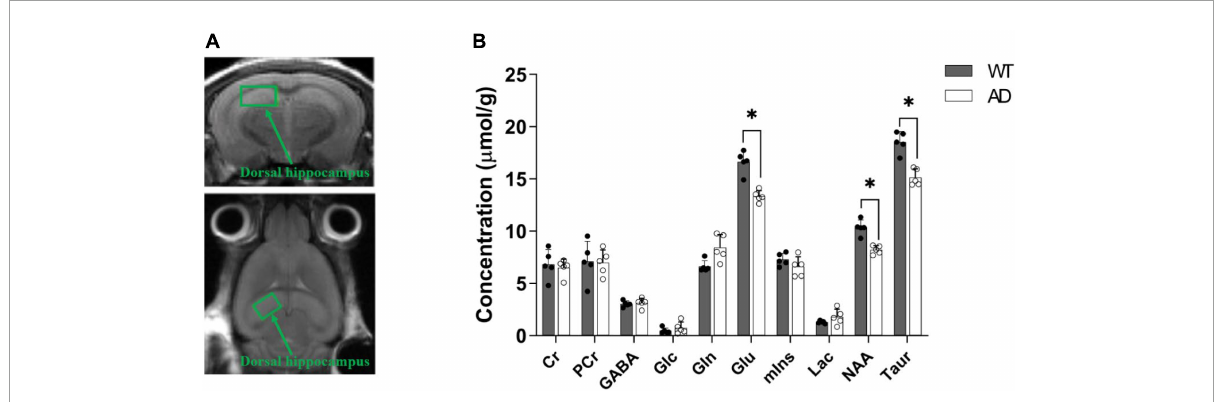
FIGURE7 Definition of the volume of interest (i.e., dorsal hippocampus) in magnetic resonance spectroscopy (MRS) (A) . Comparison of the neurochemical profiles between the wild-type (WT) and APPswe/PS2 mice (B) . Data are presented as the mean ± SD ( n = 5). A p -value < 0.05 was considered statistically significant (* p <